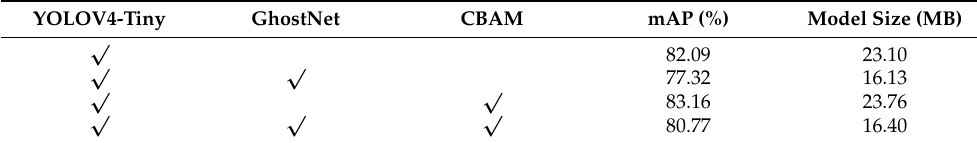
Table 2. Ablation experiments from YOLOV4-Tiny to YOLOV4-Tinier on the proposed